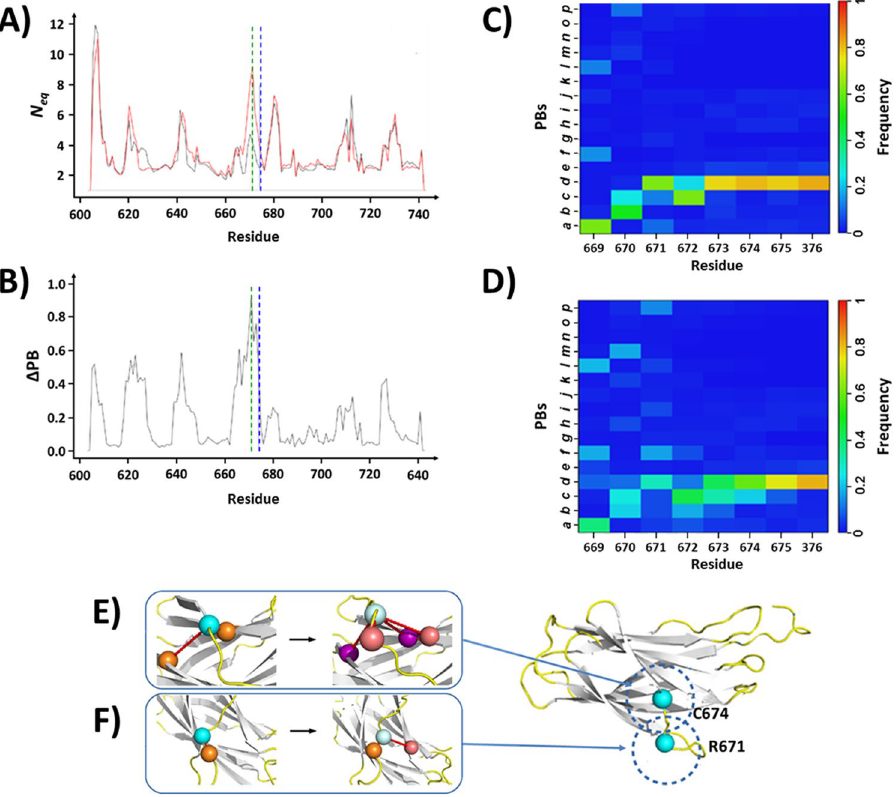
Figure 8. The variant C674R. Panels (A and B) respectively show the N eq and the Δ PB curves of the C674 (WT) and R674 (variant) systems. Panel C show the PB maps of residues 669 to 676 for the WT (above) and the variant forms (below). ( D ) Molecular interactions made by the residues C674 or R674 and ( E ) R671. For colour scales and residue presentation, see the legend of Fig.